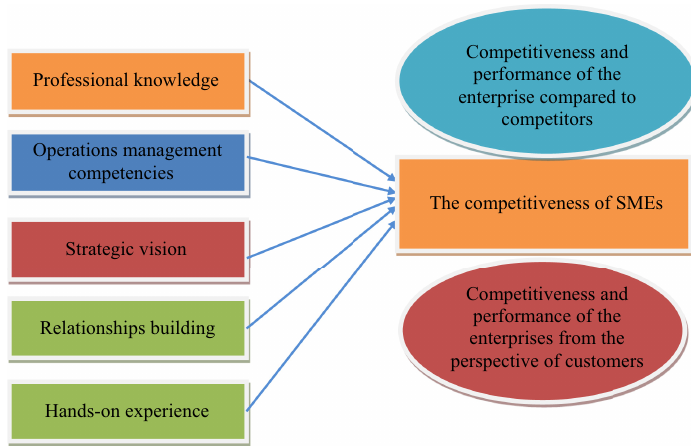
Figure 1. Research